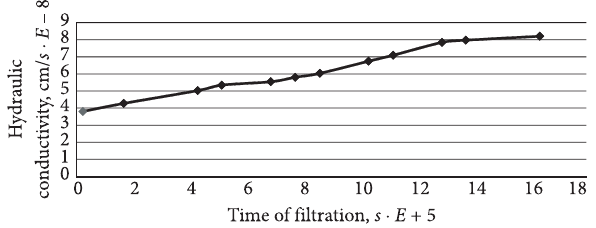
Fig. 3. Hydraulic conductivity of the same clay sample versus the filtering time at the renewal of the experiment after two